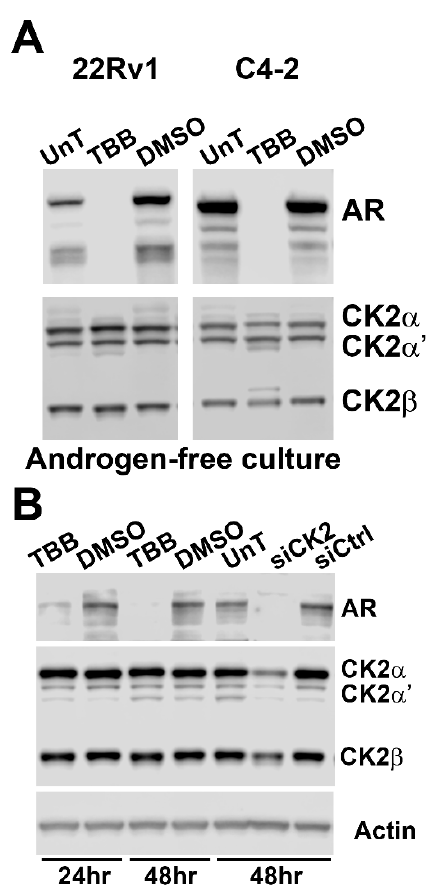
Figure 6. Androgen is not required for CK2 block-mediated loss of AR protein levels, and AR loss is equivalent in non-malignant RWPE-1 cells. ( A ) C4-2 and 22Rv1 cells grown under androgen-free conditions were treated with 80 µM TBB or equivalent concentration of DMSO. Cells were collected 48 h post-treatment for analysis by immunoblot. ( B ) RWPE-1 cells were treated with 80 µM TBB or equivalent concentration of DMSO or transfected with CK2 αα ’-targeted and control siRNAs. Cells were analyzed by immunoblot at the time points indicated below the panels. For all panels: treatment conditions are indicated above the lanes, and proteins detected indicated to the right of the panels, and actin was used as a loading control.